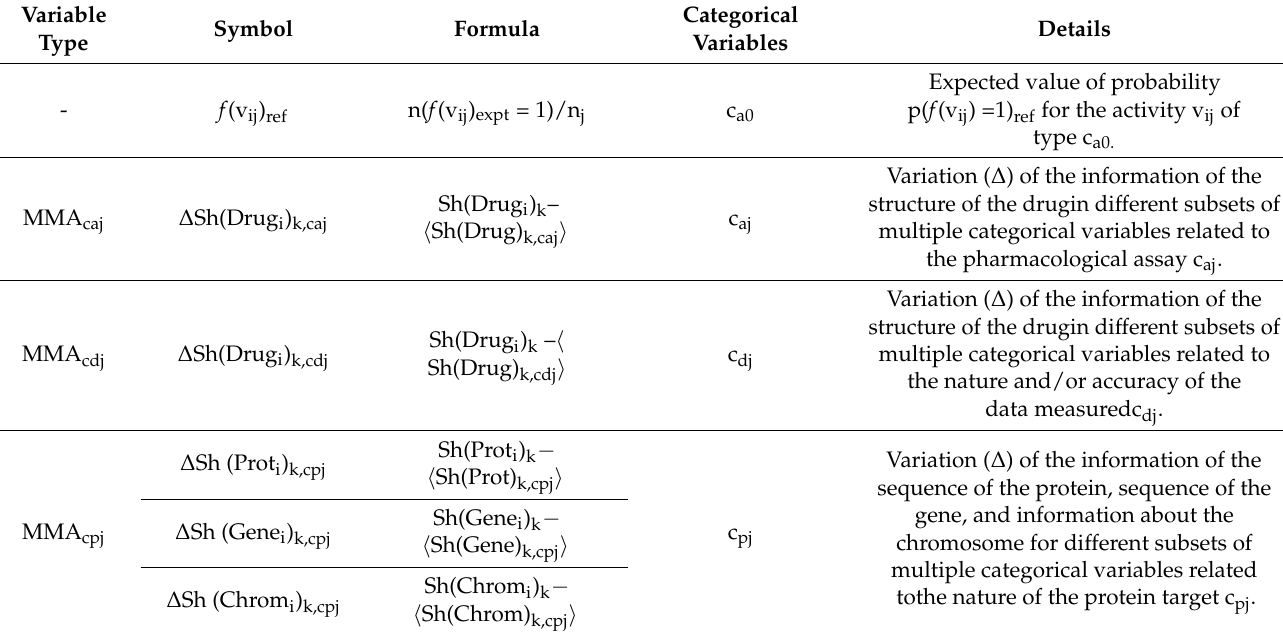
Table 8. Input variables of the IFPTML models